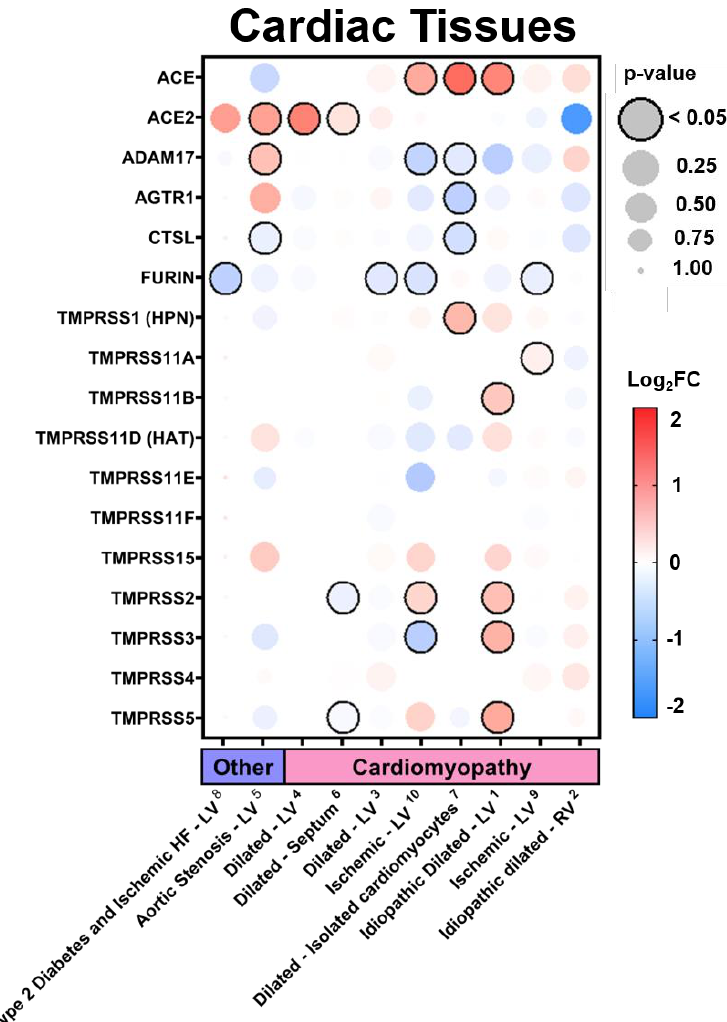
Figure 4. SARS-CoV-2 viral-entry gene expression in cardiac tissues across comorbidities. Expression of select SARS-CoV-2 viral-entry genes in cardiac tissues across 10 DataSets representing various common comorbidities. Values are displayed as logarithm to base 2 of the fold change (log 2 FC) in comparison with respective una ff ected control samples from each DataSet. Comorbidity groups and each DataSet within are sorted from greatest ( left ) to least ( right ) expression of ACE2. Heatmap coloration is set to a scale of − 2 (blue) to 2 (red) and values beyond this range are shown as either − 2 or 2, respectively. Statistical significance is represented proportional to dot size where largest dot size indicates highest statistical significance as indicated in the key and a black border designates p < 0.05. Superscript numbers link each DataSet to additional information found in Appendix A and Supplementary File 1. HF = heart failure; LV = left ventricle; RV = right